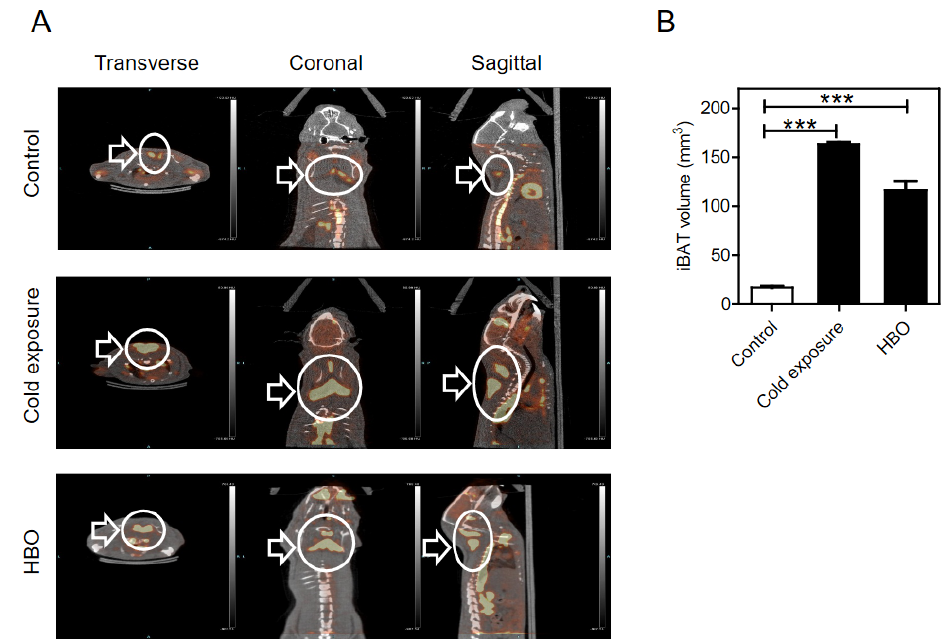
Figure 1. PET/CT images following cold exposure and HBO conditions. ( A ) Transverse (left), coronal (middle), and sagittal (right) views of PET/CT showing HBO-induced brown adipose tissues in Sprague-Dawley rats. White arrows indicate 18 F-FDG uptake in the interscapular BAT. ( B ) Quantitative analysis of BAT volumes. Volumes of interest (VOIs) were drawn on PET images using PMOD software as described under “Materials and Methods.” Values are presented as ± S.E.M *** p < 0.001 compared to control ( n = 5 per each condition).